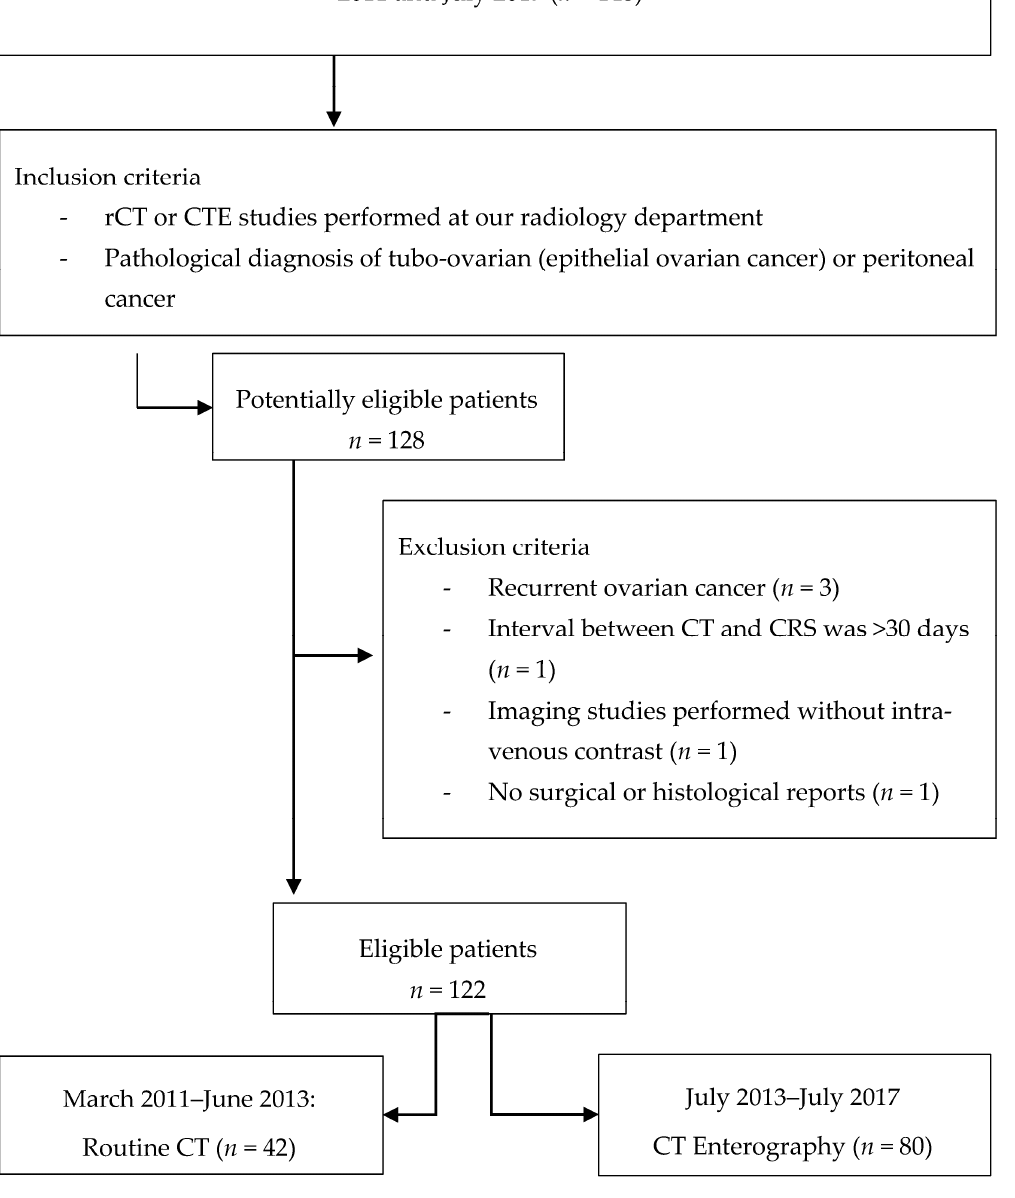
Figure 1. Flow diagram of the participants included in the study. Table 1. Clinicopathologic and general characteristics of the 122 patients with advanced ovarian cancer treated by cytoreductive surgery.